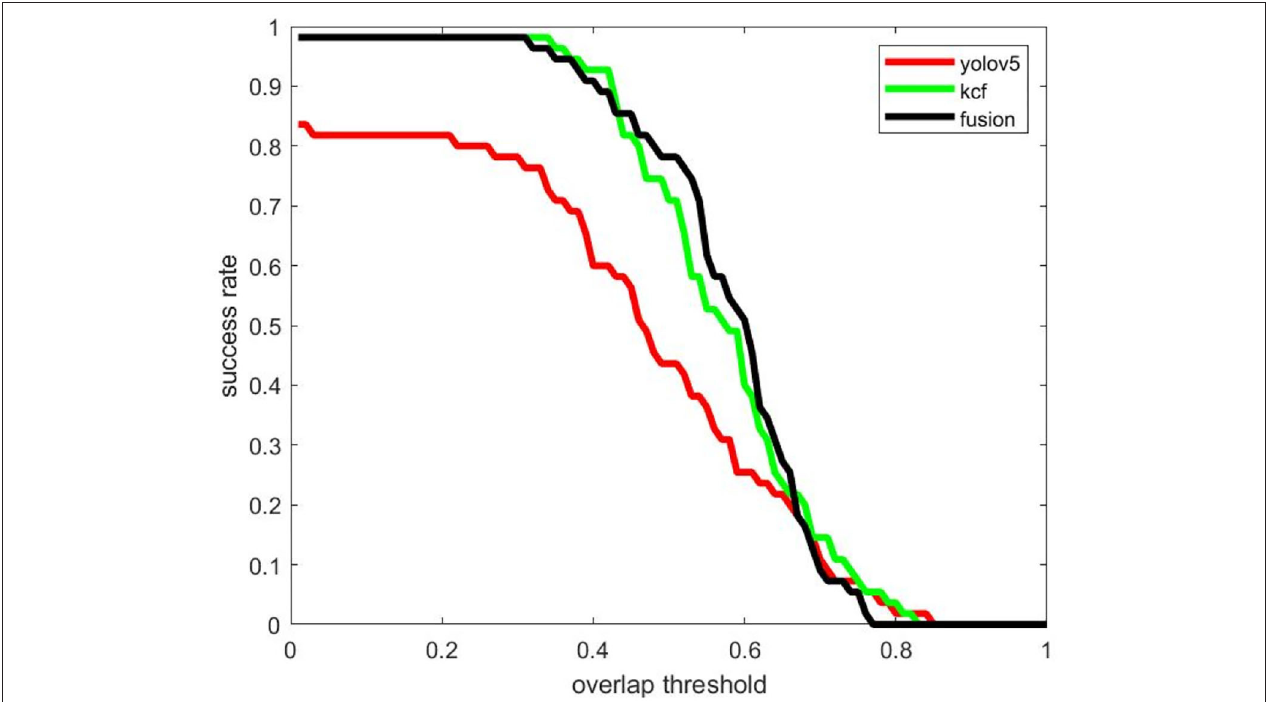
FIGURE 14 | Comparison of detection and tracking success rates using KCF, Yolov5, and fusion algorithms (Video 3).